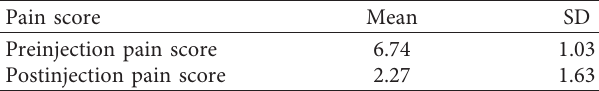
Table 5: Outcome of musculoskeletal steroid injections in terms of pain score before and after